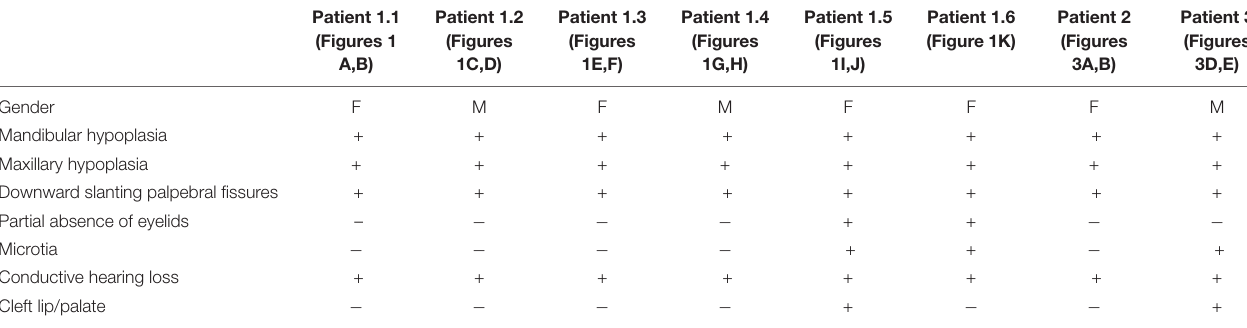
TABLE 3 | Summary of clinical data in reported patients with Treacher Collins syndrome